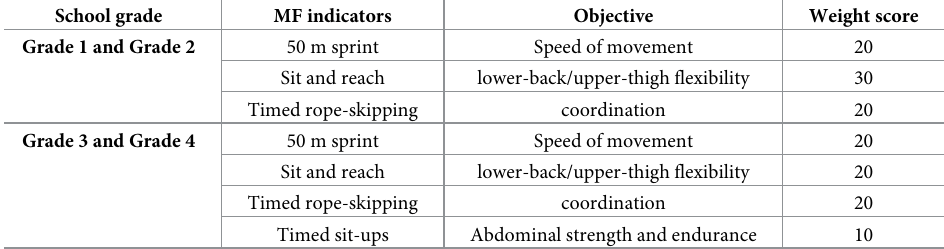
Table 2. MF indicators and weight coefficient on CNSPFS among students of different